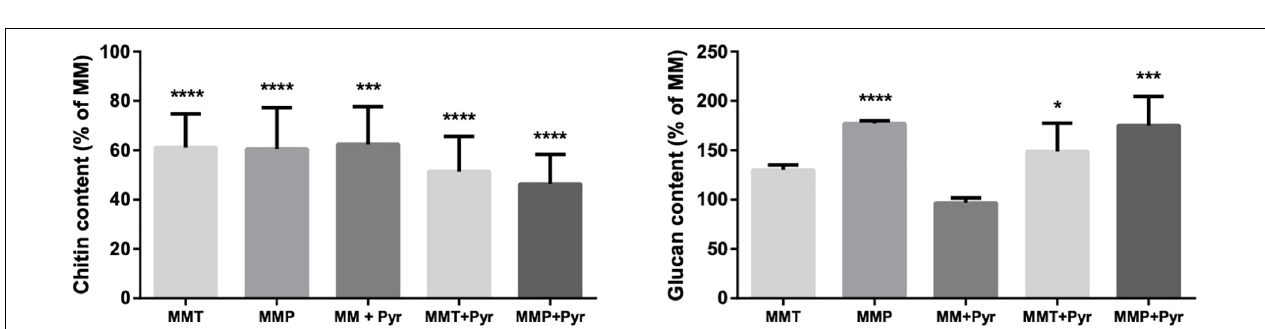
FIGURE 7 | Transmission electron micrograph of the melanin ghosts prepared from A. alternata hyphae grown in MM (A,D) , MMT (B,E) and MMP (C,F) . Bars, 1,000 nm in (A–C) and 2,000 nm in (D–F) .